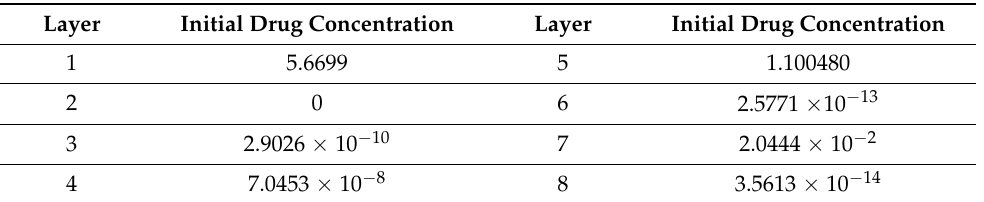
Figure 6. Drug release profiles for different layers NL = 8, 9, 10. (Case 3). Table 6. Initial drug concentration at each layer of the drug-controlled release system with NL = 8 (Case 3).